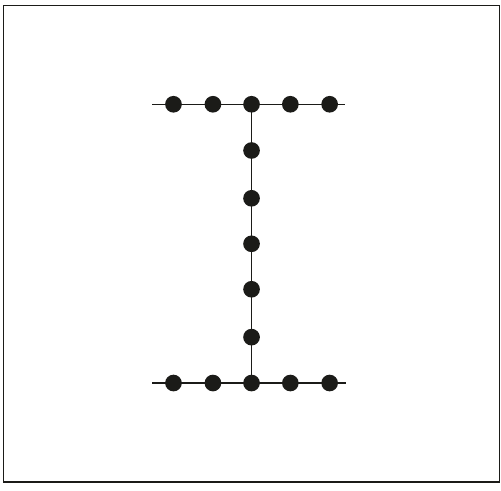
Figure 2: Discretization of the steel in the SRC column.